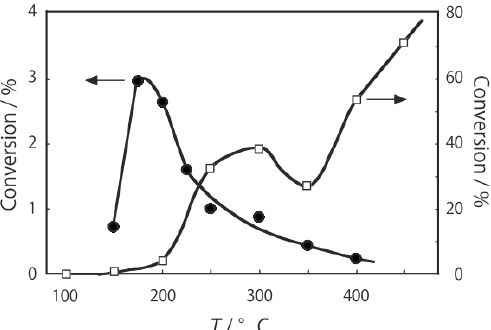
Figure 12. Effect of preliminary activation temperature on catalytic activity of [(Nb Cl )Cl (H O) ]·4H O. Following the activation of the cluster in a hydrogen stream at 6 12 2 2 4 2